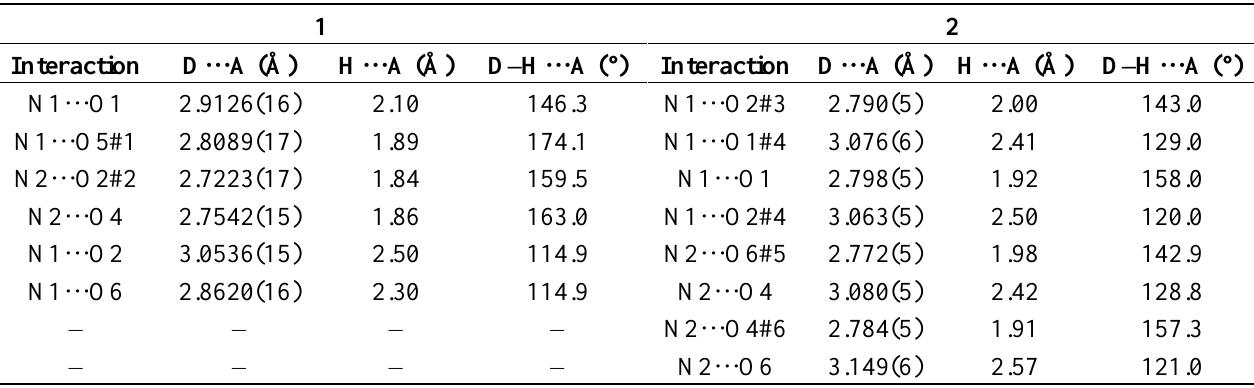
Table 1. Hydrogen-bonding parameters for compounds 1 and 2 . Symmetry